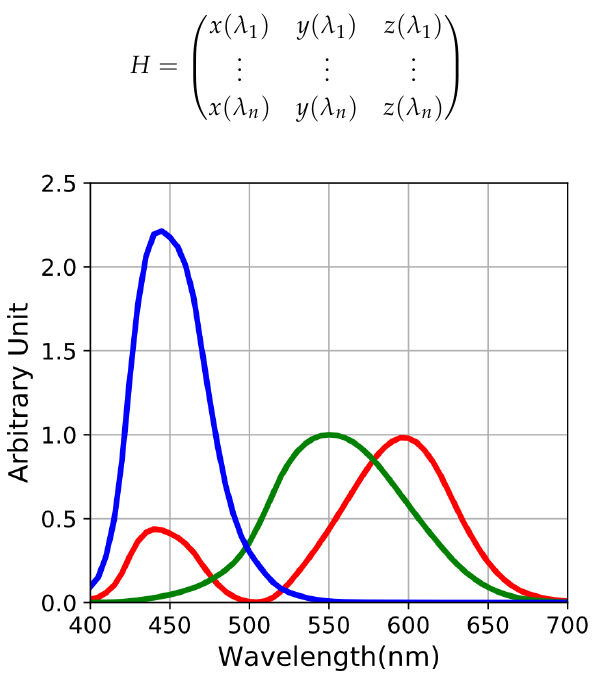
Figure 10. Color matching functions expressed to be used with radiances in photon flux